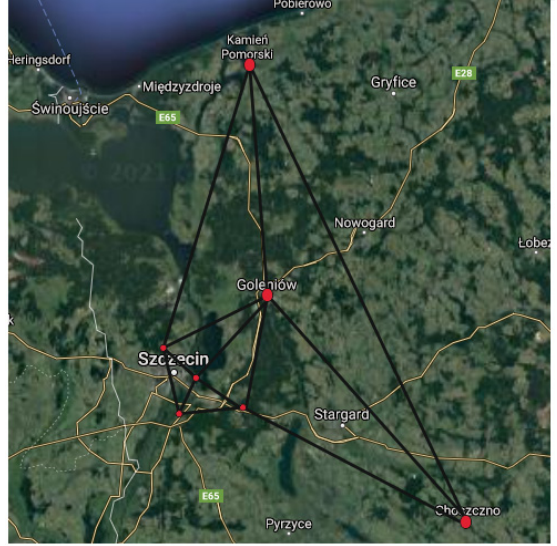
Figure 6. Location of measurement sites in relation to the nearest reference stations: Choszczno, Goleniów, and Kamie ń Pomorski.